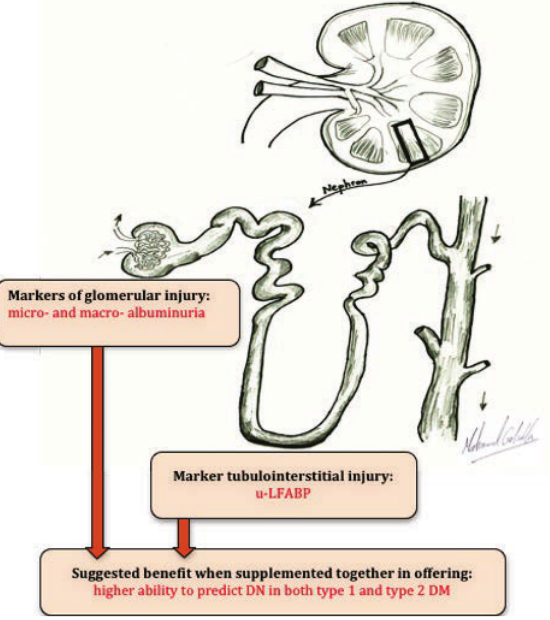
Figure 3. A simplified diagram illustrating urinary markers of DN development and progression, including markers of glomerular injury and tubulointerstitial injury. Recent evidence suggest a higher predictor ability when markers of glomerular injury are supplemented by u-LFABP, a marker of tubulointerstitial injury Artwork provided as a courtesy of Mahmoud R Gaballa,